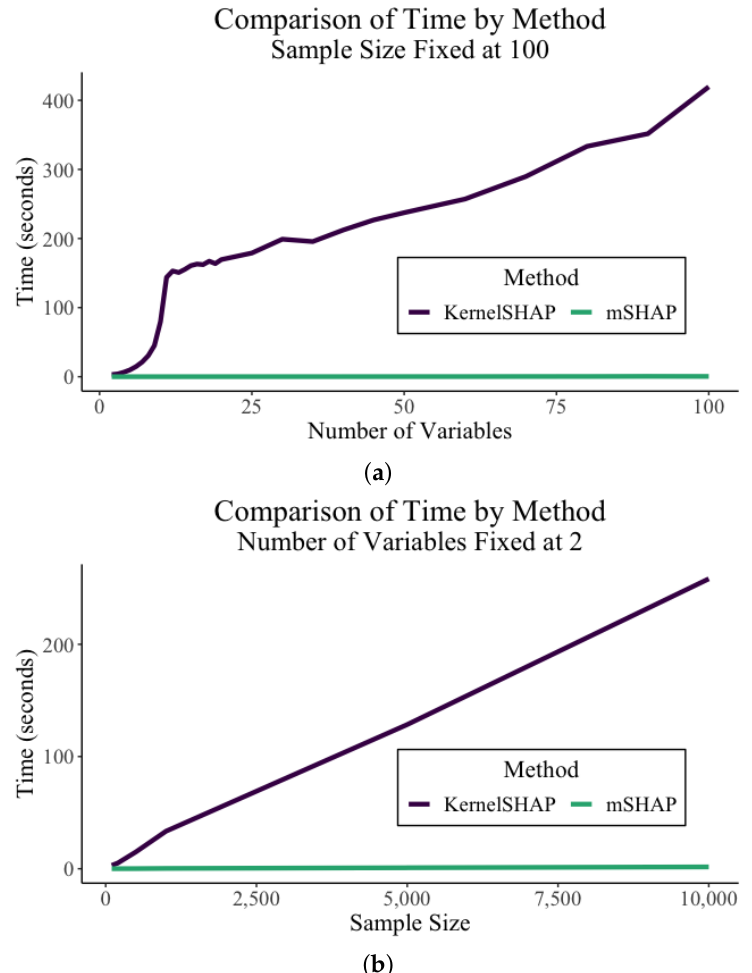
Figure 4. Computational time of kernelSHAP and mSHAP. ( a ) Fixed n . ( b ) Fixed number of